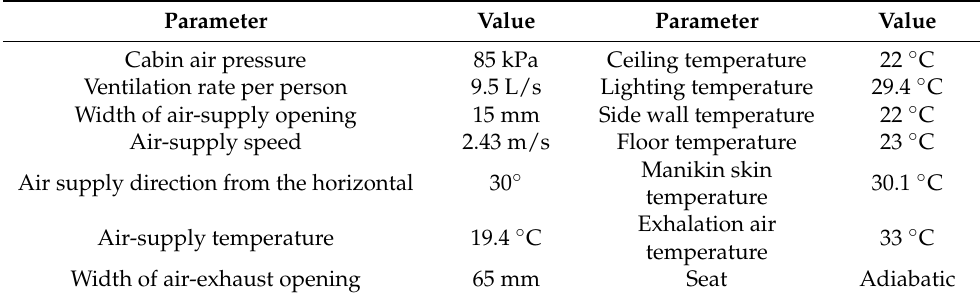
Table 5. Major thermo-flow boundary conditions.